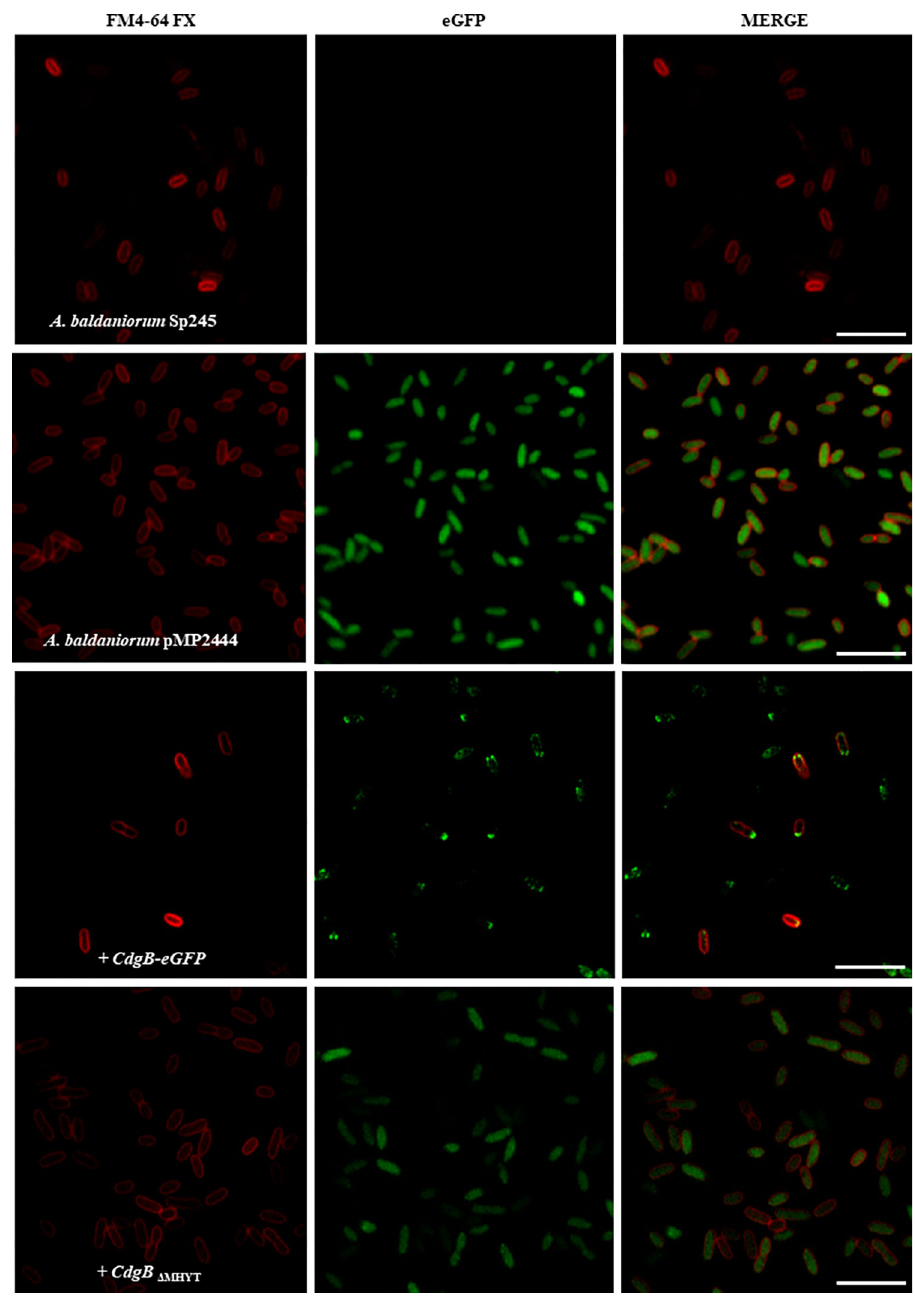
Fig 9. CdgB is anchored to the cytoplasmic membrane and polarly localized. The first two columns (left to right) show representative images acquired to detect fluorescence of the FM4-64FX fluorophore (red) that bind to lipidic membranes, and fluorescence from the eGFP protein (green). The third column shows images where the two fluorescent signals were merged. The white arrowheads indicate polar localization of CdgB protein. The white bar corresponds to 10 μ